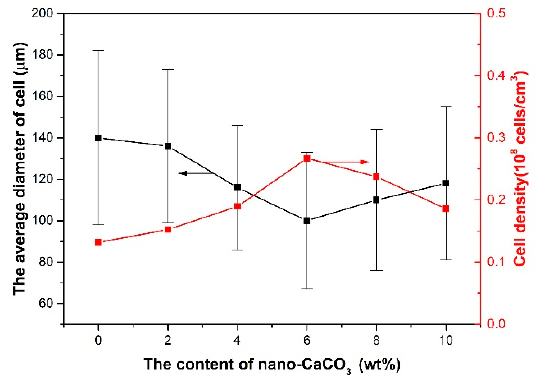
Figure 19. The average cell diameter and cell density of the core layer of parallel sections with different